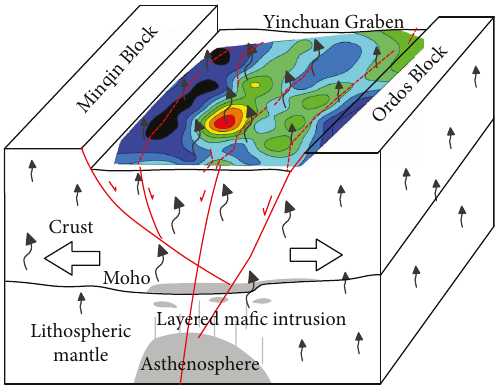
Figure 6: Sectional view of CH (modi fi ed after [6,